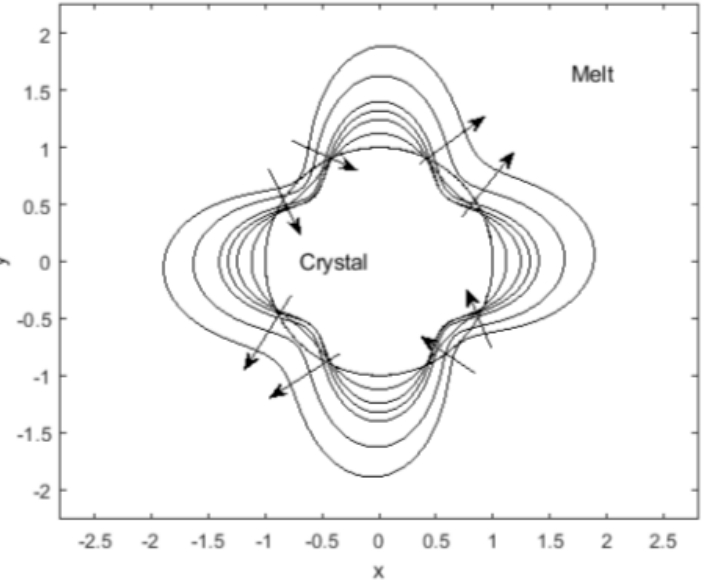
Figure 3. The cross-sectional curves of the interface morphology of the columnar crystal affected by shear rate of the forced flow at different times t = 0,0.10,0.30,0.60,1.0,2.0,3.0, where A 0 = B 0 = 40, α 4 = 0.25, r 0 = 1.1 R ∗ , Γ = 0.4545, and ∆ T = 10. By contrast, the dashed line (the circular line) denotes the columnar crystal without the shear effect of the forced flow. Arrows indicate crystal growth trends.